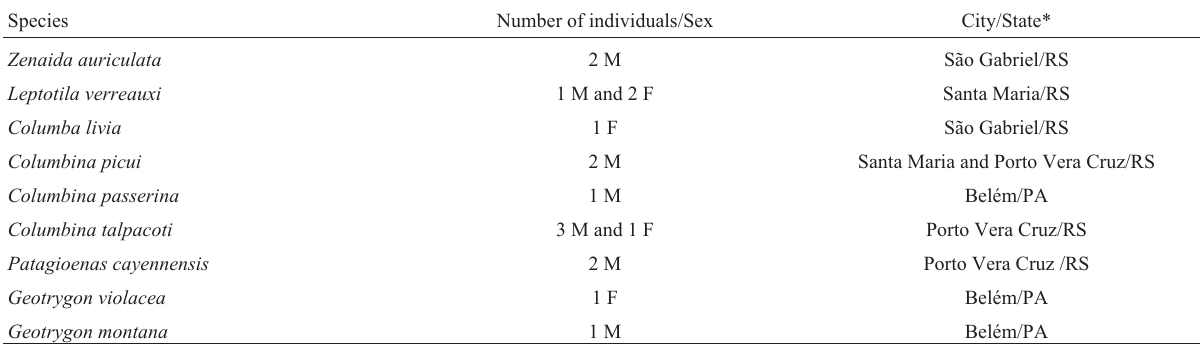
Table 1 - Information concerning the individual samples used for this study. Species